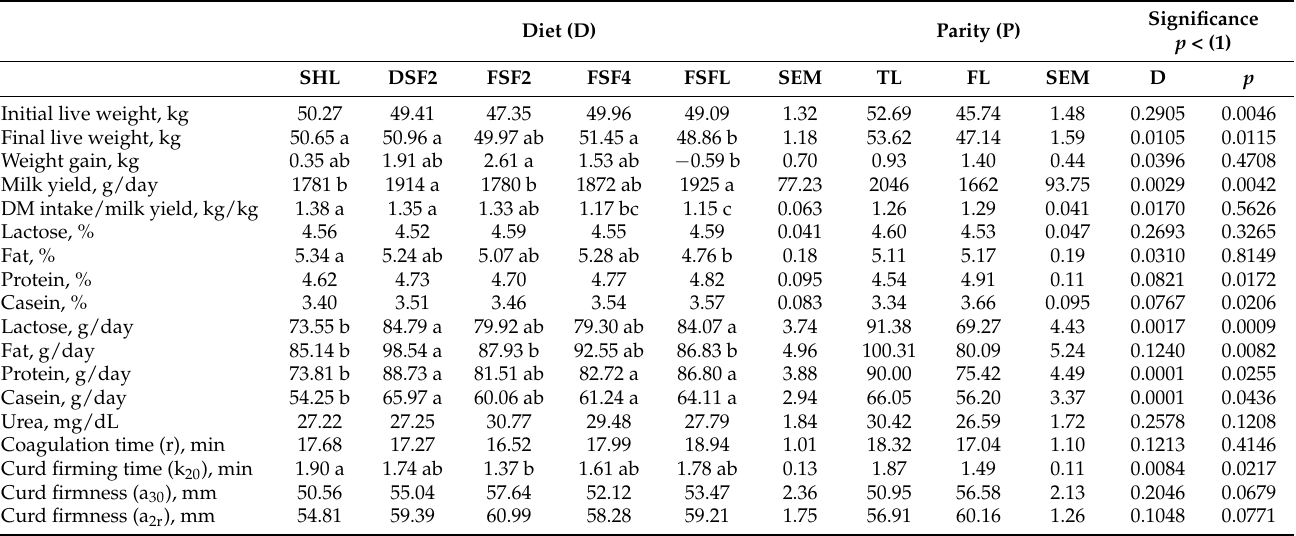
Table 3. Effect of diet and parity on live weight variation and individual milk yield and